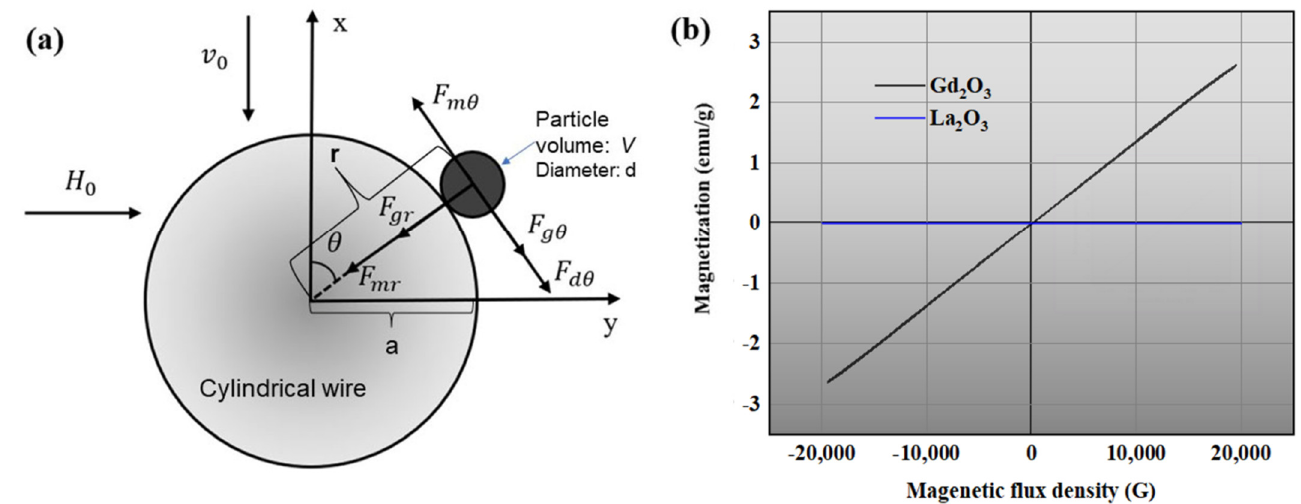
Figure 3. Experimental procedure of the HGMS method.